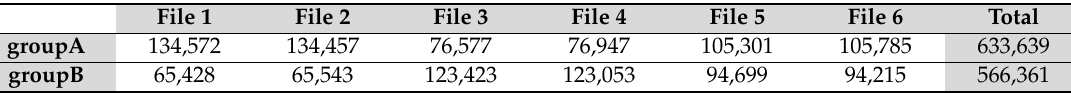
Table 4. Number of connection classes in every file in the gureKDD dataset.